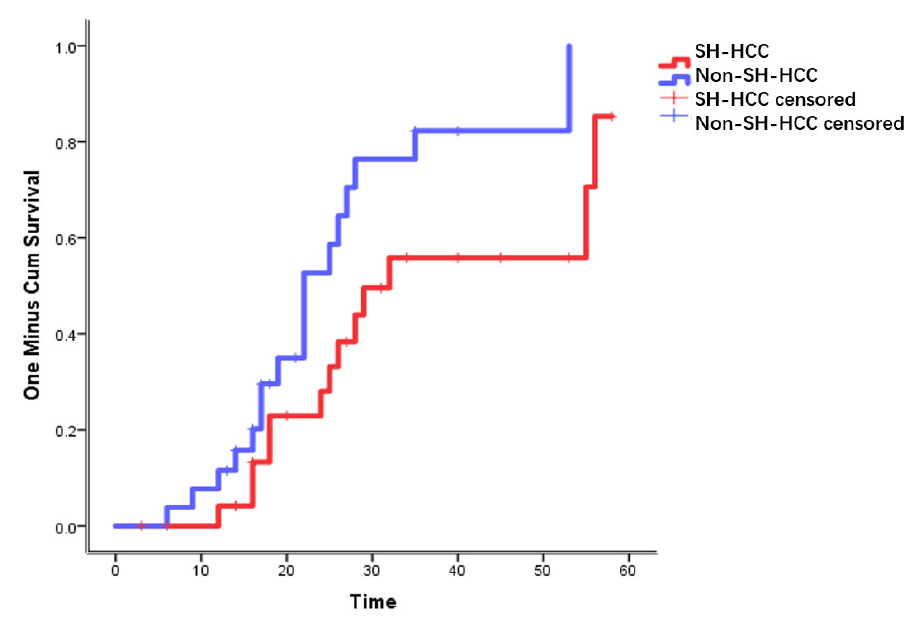
Figure 4. The recurrence curve of SH-HCC and non-SH-HCC patients.